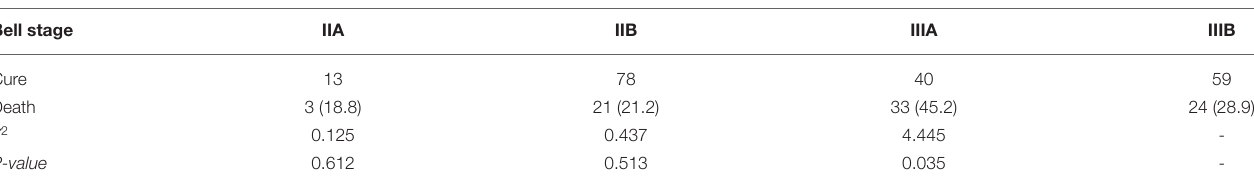
TABLE 3 | Death in different Bell stages [n